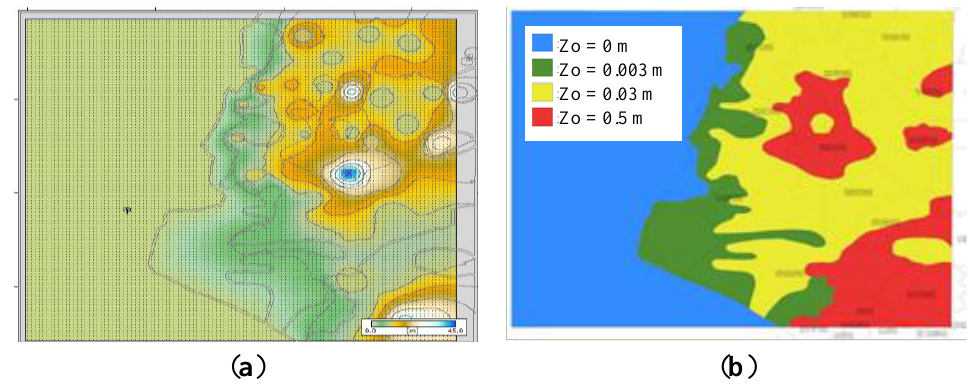
Figure 5. Contour map and surface roughness diagram in the Tainan area. ( a ) 5-m contour map; ( b ) Surface roughness diagram.